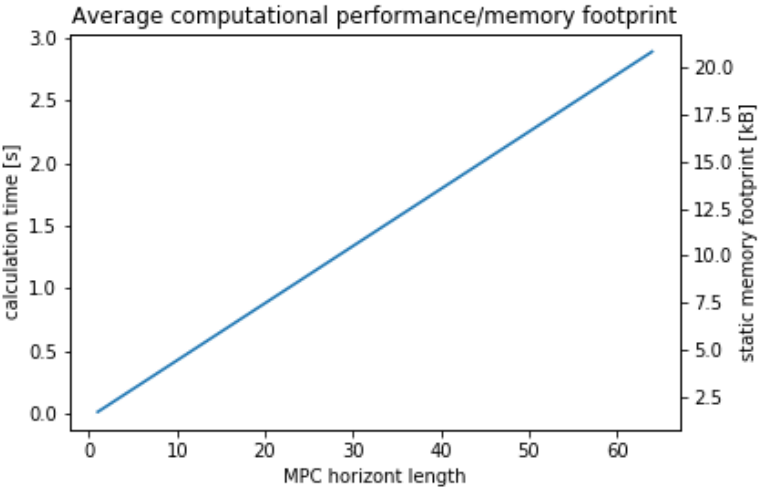
Figure 8. Empirically determined average runtime ˆ T ctrl of the MPC control task for different control horizon lengths running on the STM32F4 node.